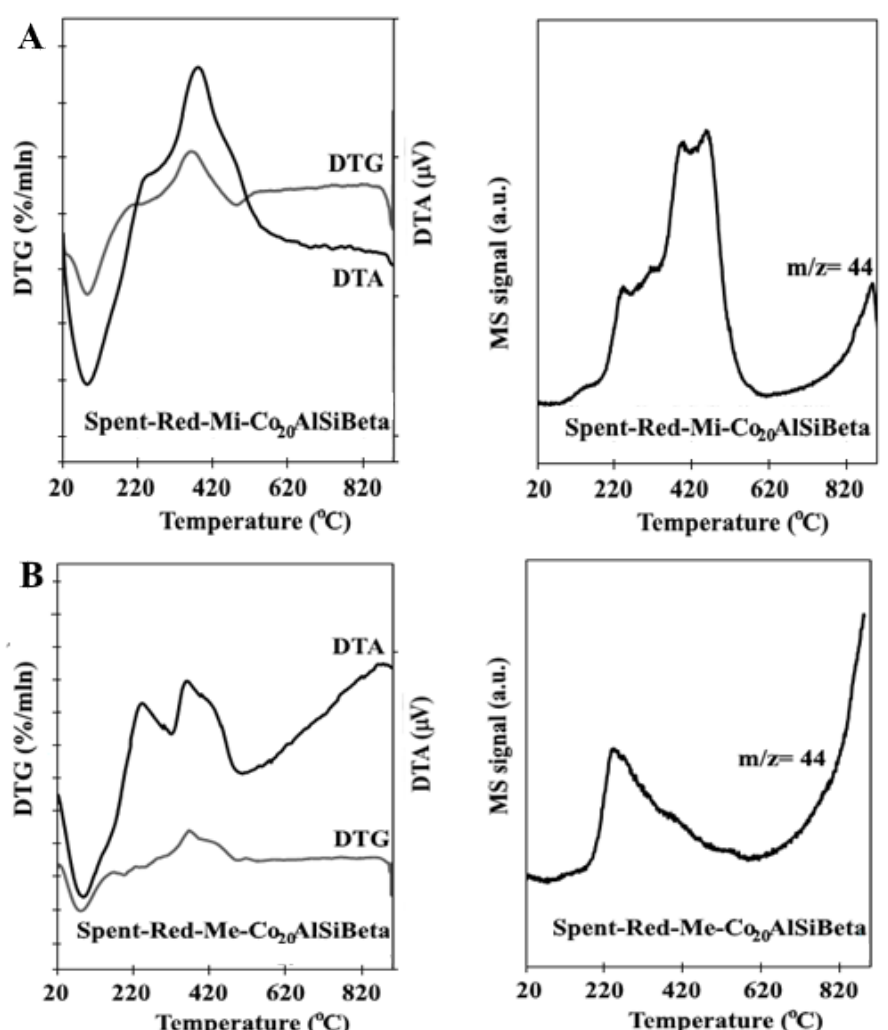
Figure 16. Investigation of carbon deposition on the ( A ) Spent-Red-Mi-Co 20 AlSiBeta and ( B ) Spent-Red-Me-Co 20 AlSiBeta.